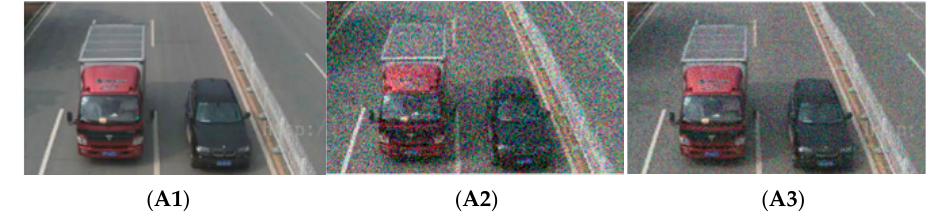
Figure 16. Vehicle images: model performance trained with 180 × 180 image size. ( A1 ) The original image; ( A2 ) the noisy image; ( A3 ) denoised image with σ = 25 .